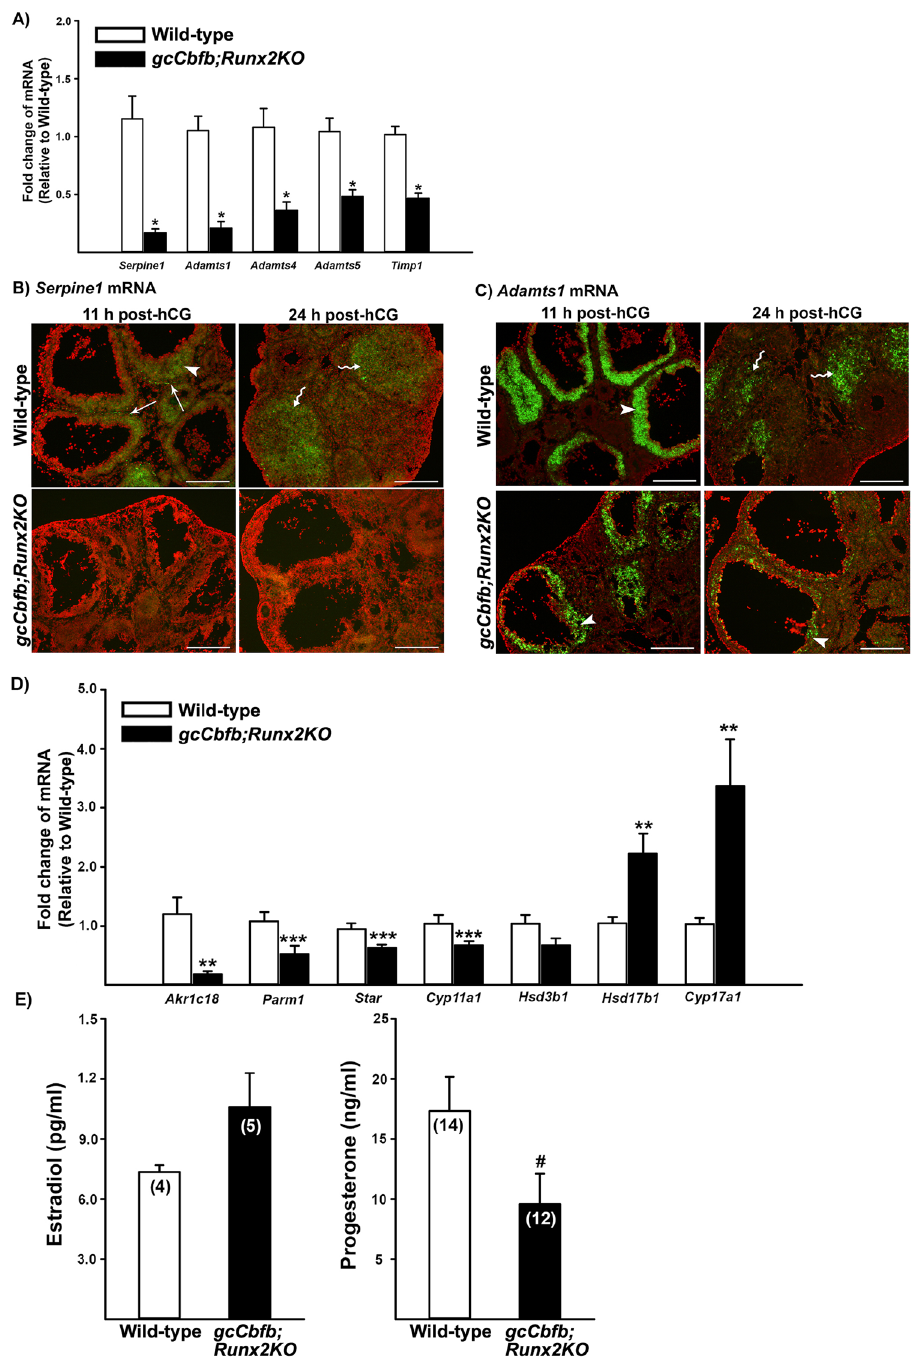
Figure 5. Identification of down-regulated genes in ovaries of gcCbfb;Runx2KO mice (II). Ovaries were collected at 11 h after hCG administration from wild-type and gcCbfb;Runx2KO mice. ( A ) The levels of mRNA for a cluster of genes associated with tissue remodeling were measured by qPCR, normalizing to the Rpl19 value in each sample (n = 8 and 7 for control and mutant mice, respectively). * p < 0.005. ( B & C ) The localization of mRNA for Serpine1 and Adamts1 was detected via in situ hybridization analyses in ovaries collected at 11 and 24 h post-hCG (n = 3/genotype). Transcripts for these genes were detected as green fluorescence signals. The tissue sections were counterstained with propidium iodide (red). Arrowheads, arrows, and wavy arrows point to granulosa cells of preovulatory follicles, cells in the theca layer, and luteal cells in the corpus luteum stained positive for these gene transcripts, respectively. Scale bars, 250 μ m for all the images. ( D ) The levels of mRNA for genes known to be involved in steroid metabolism were measured by qPCR, normalizing to the Rpl19 value in each sample (n = 8 and 7 for control and mutant mice, respectively. ** p < 0.01. *** p < 0.05. E ) The levels of serum estradiol and progesterone were measured in blood samples collected at 11 h after hCG administration. The number inside each bar represents the sample size of mice evaluated. # p =